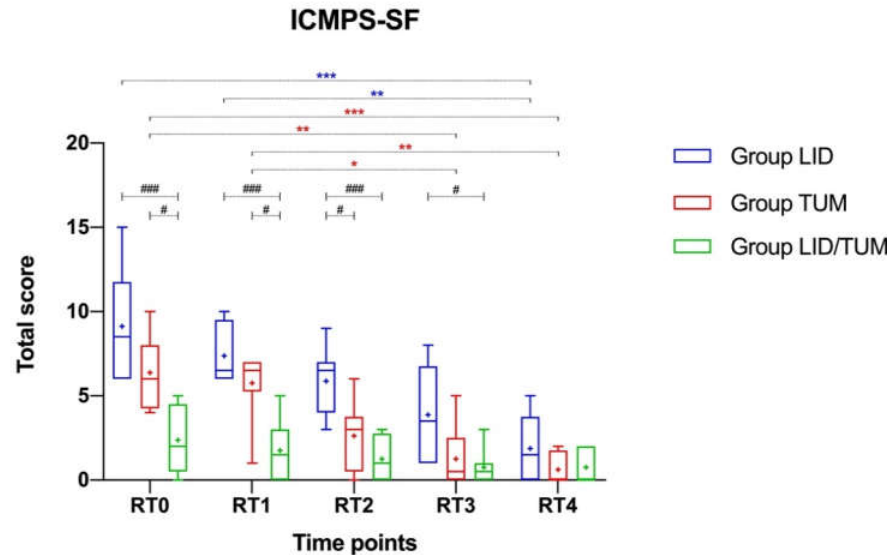
Figure 6. Boxplot showing the postoperative pain scores using the Italian version of the Glasgow Composite Pain Scale-Short Form (ICMPS-SF) in Lidocaine Group (Group LID), Tumescent anesthesia group (Group TUM), Lidocaine/Tumescent anesthesia group (Group LID/TUM). Time points, RT0: postoperative achievement of full recovery from the sedative effects from the anesthetic drugs; RT1: 15 min after RT0; RT2: 30 min after RT0; RT3: 45 min after RT0; RT4: 60 min after RT0. The ends of the whiskers show minimum and maximum score values; boxes show the median, the first and the third quartile; blue, red and green + show the mean values. Blue and red asterisks indicate sta- tistical significance within each group. Black hashtags indicate statistical significance between groups. p -values, */#: p < 0.05; **/###: p < 0.01; ***: p < 0.001. Considering separately the item response to touch included in ICMPS-SF, no differ- ences between groups were found. A progressive decrease tendency appeared within each group, with the lower mean score ± s.d. achieved at RT4 in all groups (LID: 0.75 ± 0.89, TUM: 0.25 ± 0.46, LID/TUM: 0.12 ± 0.35); the difference was not significant within Group LID (χ 2r = 3.958, p = 0.4117) while it was significant within Group TUM (χ 2r = 17.25, p = 0.0017) and Group LID/TUM (χ 2r = 12.00, p = 0.0174).